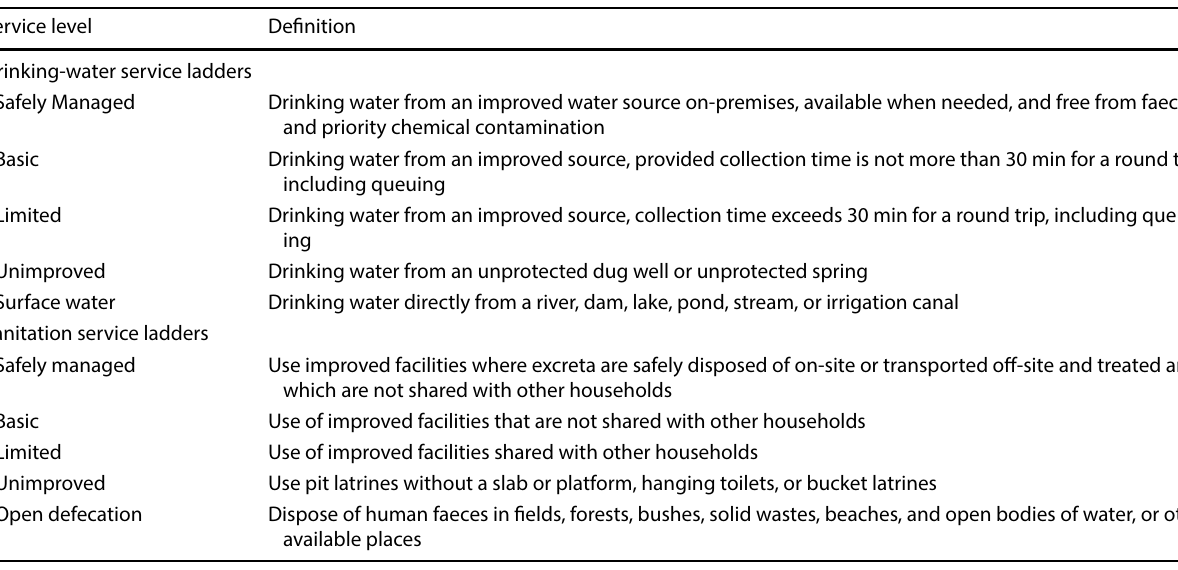
Table 1 JMP ladders for drinking water and sanitation services in households are defined below